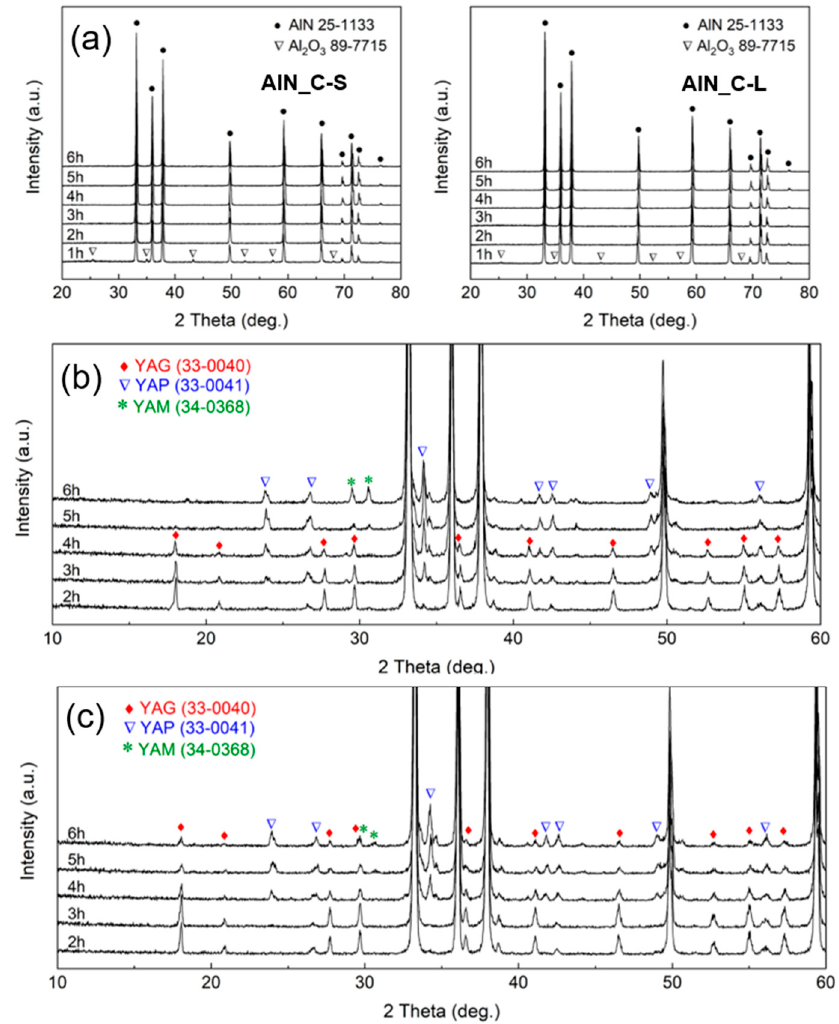
Figure 1. ( a ) Crystal structure of wurtzite-type AlN. 4-coordinated AlN 3 O defect, involving alumi- num vacancy (V Al ), and 6-coordinated AlO 6 defect are shown. ( b ) Synthesis of aluminum nitride via carbothermal reaction. Oxygen concentrations of AlN materials were controlled by carbothermal reaction time at 1700 °C. Commercial material from Tokuyama corp. was used as a reference. SEM images of alumina, carbon(C-S/C-L), and aluminum nitride (AlN_C-S, AlN_C-L) are shown in Fig- ure S1.